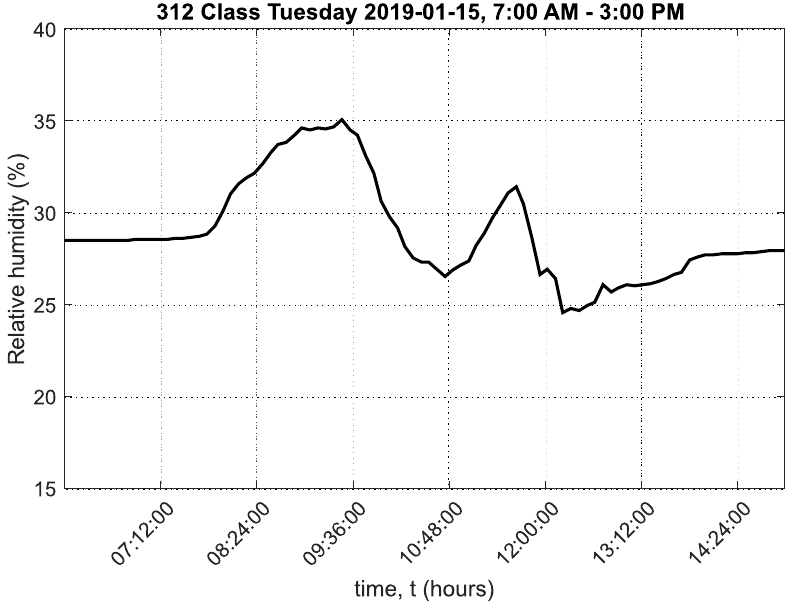
Figure A6. Graph of relative humidity of ambient air in classroom 312, Frenštát pod